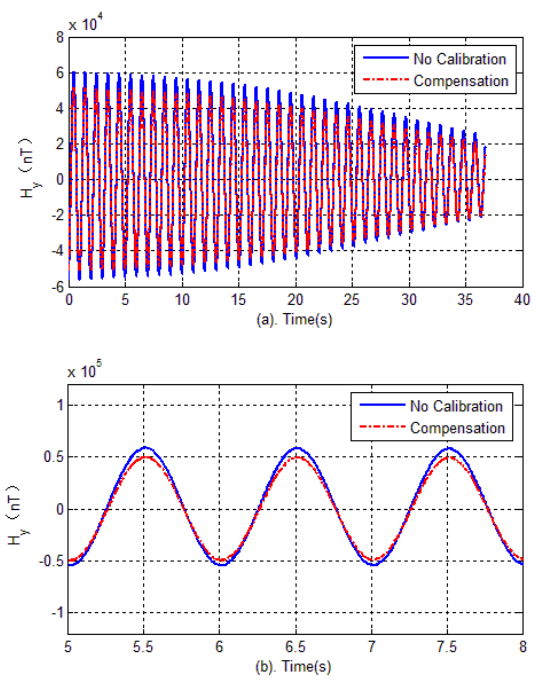
Figure 20. Magnetometer outputs of X-axis. Figure 21. Magnetometer outputs of Y-axis.